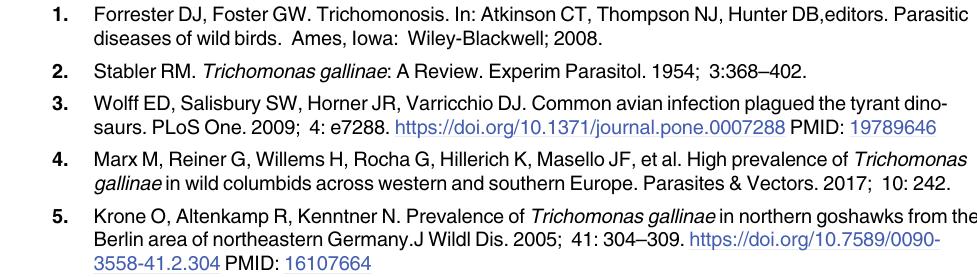
S1 Fig. Decline in greenfinch numbers in Hesse, Germany, according to the spring (https:// www.nabu.de/tiere-und-pflanzen/aktionen-und-projekte/stunde-der-gartenvoegel/index. html) and winter garden bird counts (https://www.nabu.de/tiere-und-pflanzen/aktionen- und-projekte/stunde-der-wintervoegel/index.html) of the NABU (Nature and Biodiversity Conservation Union,